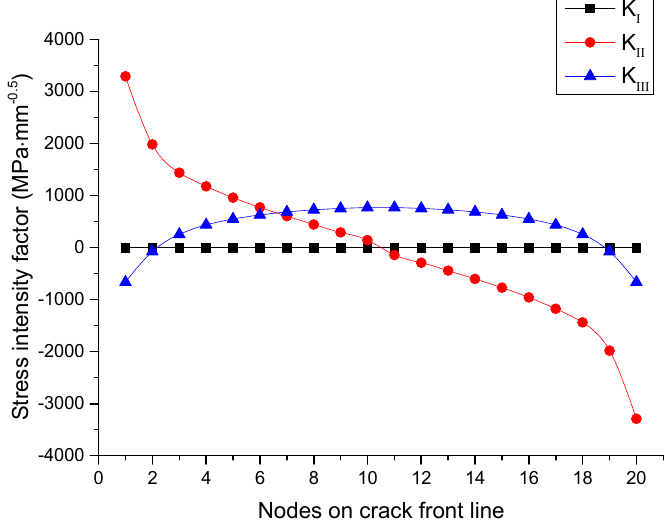
Figure 19. Distribution of Stress Intensity Factor on the crack tip line under mode III loading.